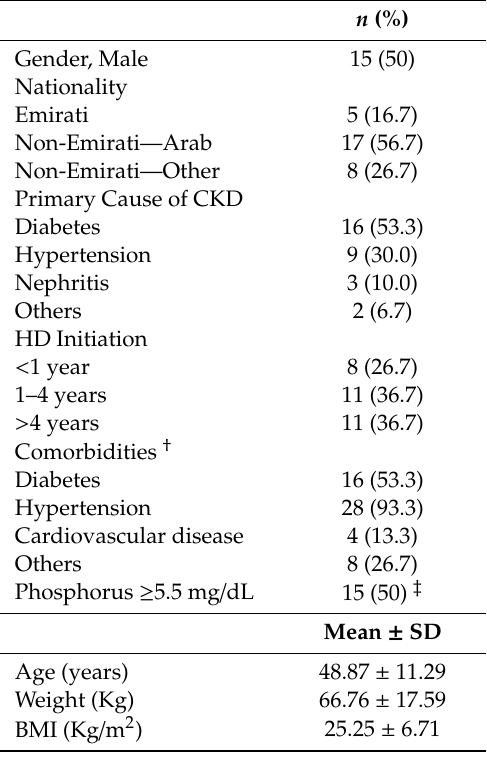
Table 1. Baseline Characteristics of patients ( n = 30).